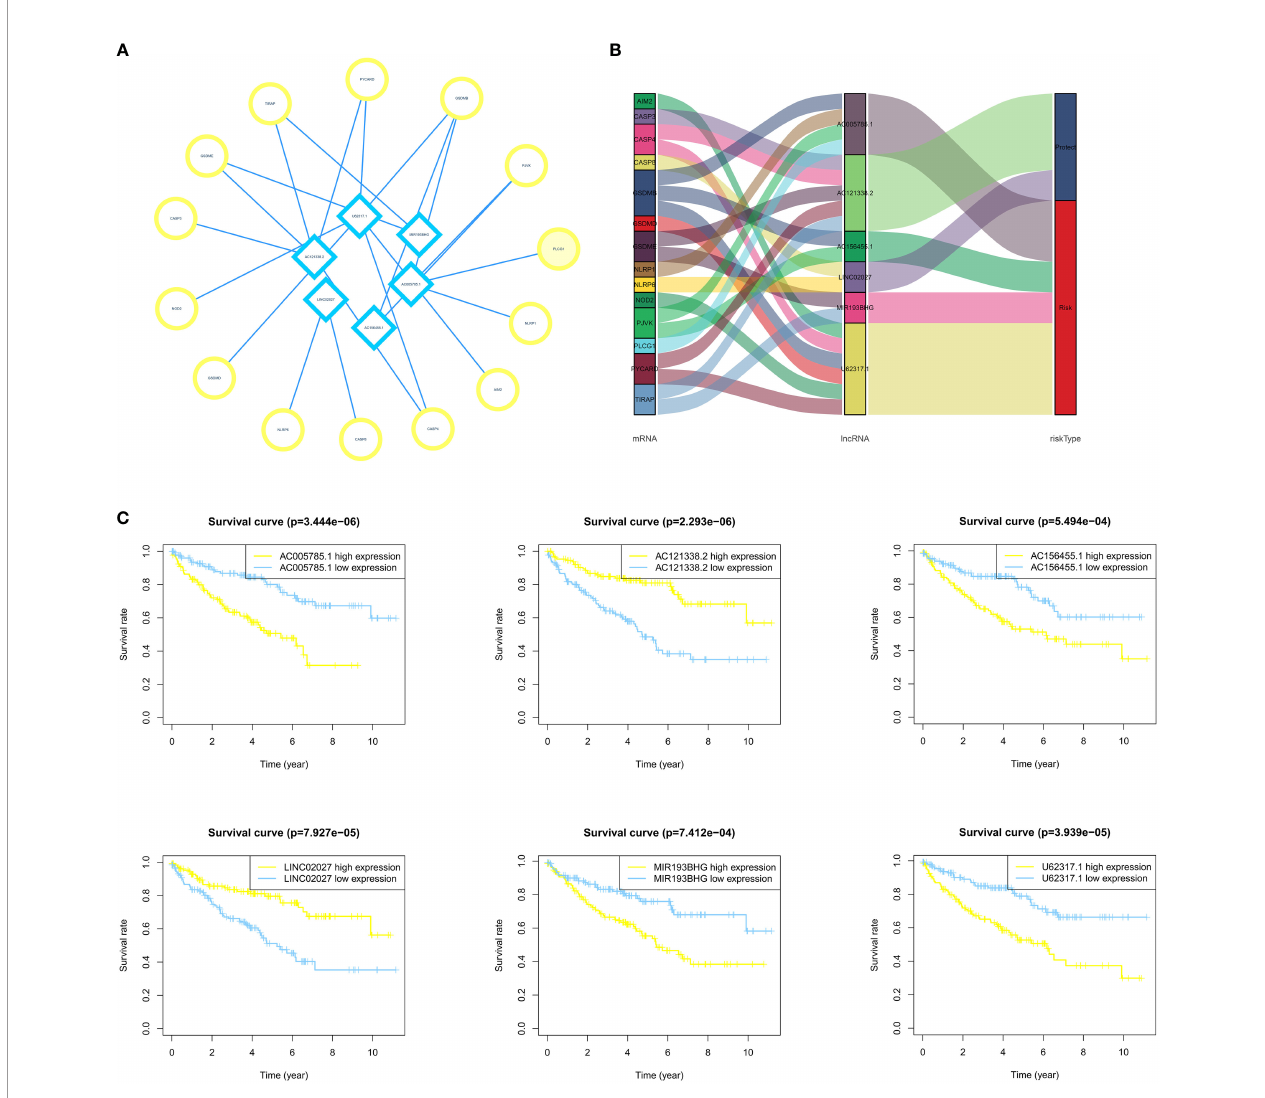
FIGURE 4 | Establishment of the LncRNA-mRNA coexpression network and survival analysis. (A, B) The LncRNA-mRNA coexpression network indicates the interaction network between PRlncRNA and mRNA. (C) The survival curves of 6 PRlncRNAs in ccRCC patients show that there is an association between these lncRNAs and patient